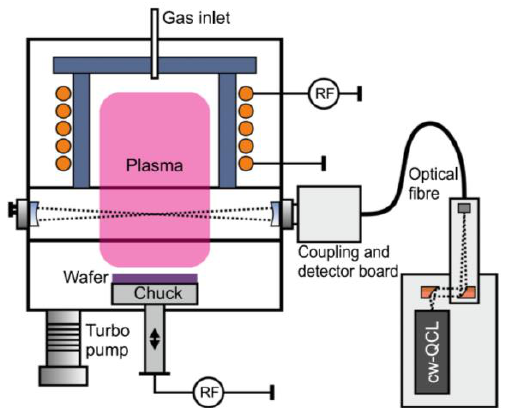
Figure 27. Outline of the Oxford Plasmalab System 100 ICP etch chamber equipped with Q-MACS Process fiber system. CF 2 radicals were detected using a multipass cell just above the wafer [59], Reproduced from [59], with the permission of AIP Publishing.